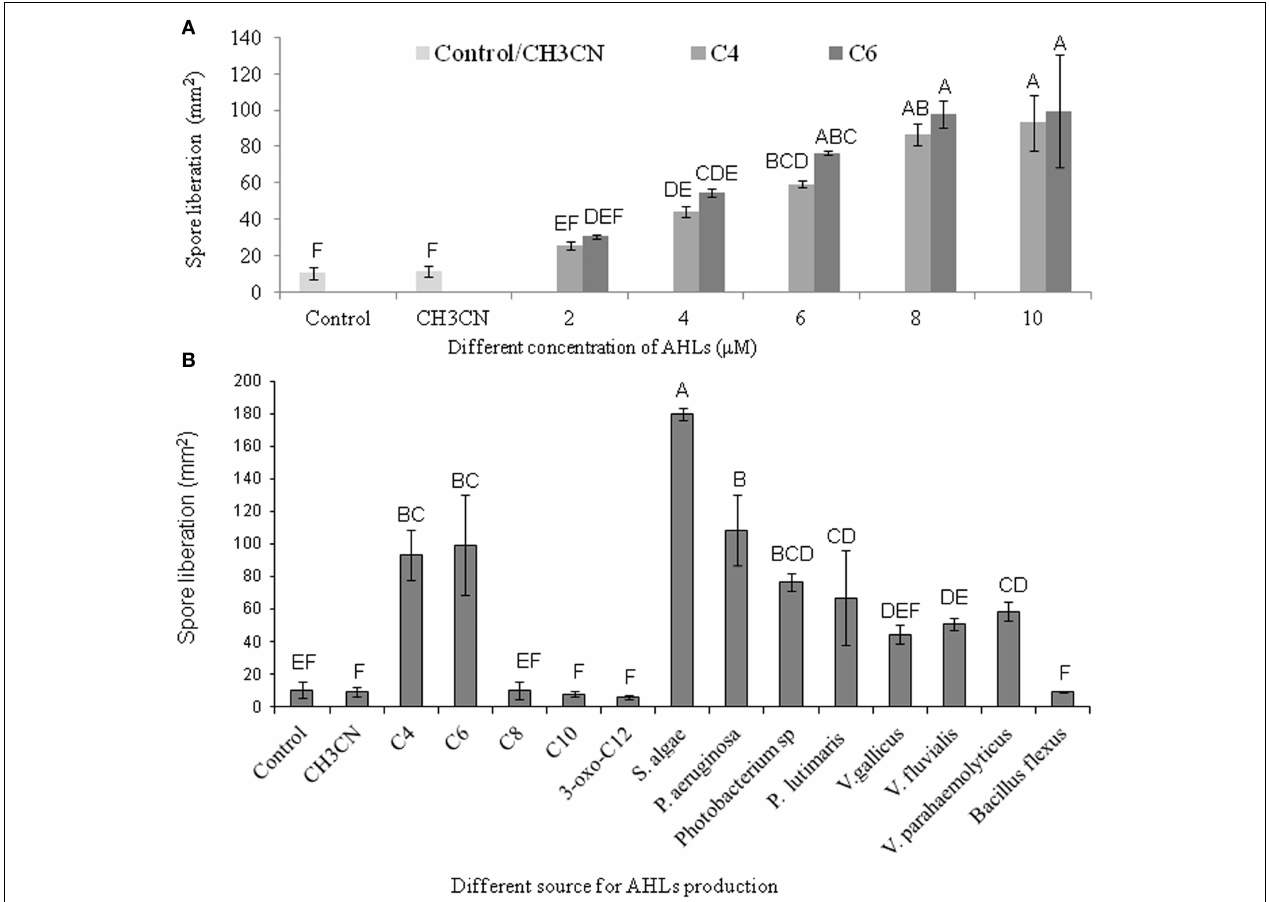
FIGURE 5 | Effect of different standard AHLs and Gram-negative bacterial isolates on carpospores liberation from Gracilaria dura . (A) Effect of different concentrations (2, 4, 6, 8, and 10 μ M) of C 4 - and C 6 -HSL on carpospores liberation. (B) Effect of different AHLs standard at 10 μ M, culture filtrates of Gram-negative bacterial isolates and Bacillus flexus on carpospores liberation. Bars indicate minima and maxima of three replicates. One Way ANOVA and Dunnett’s post-hoc analysis showed significant differences at p > 0 . 01 for the C 4 -HSL, the